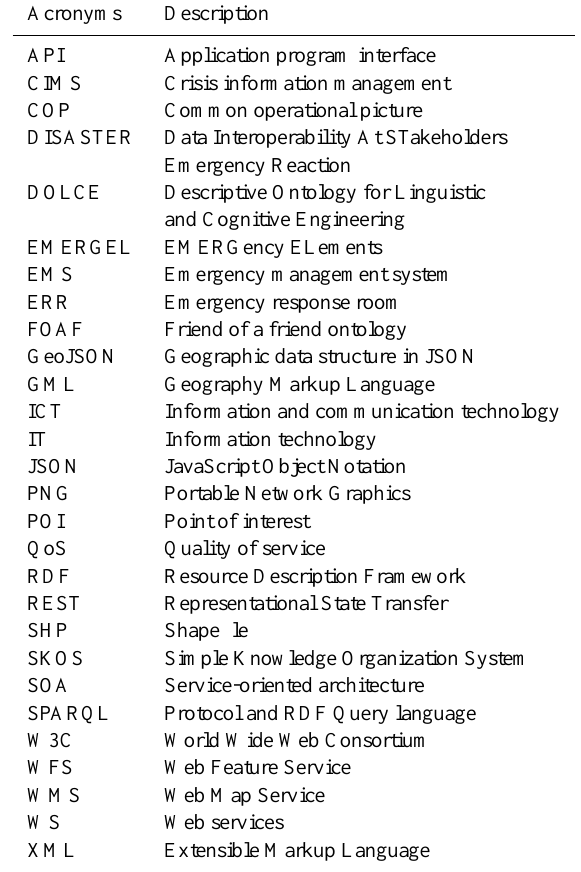
Table 1. Acronyms used in the